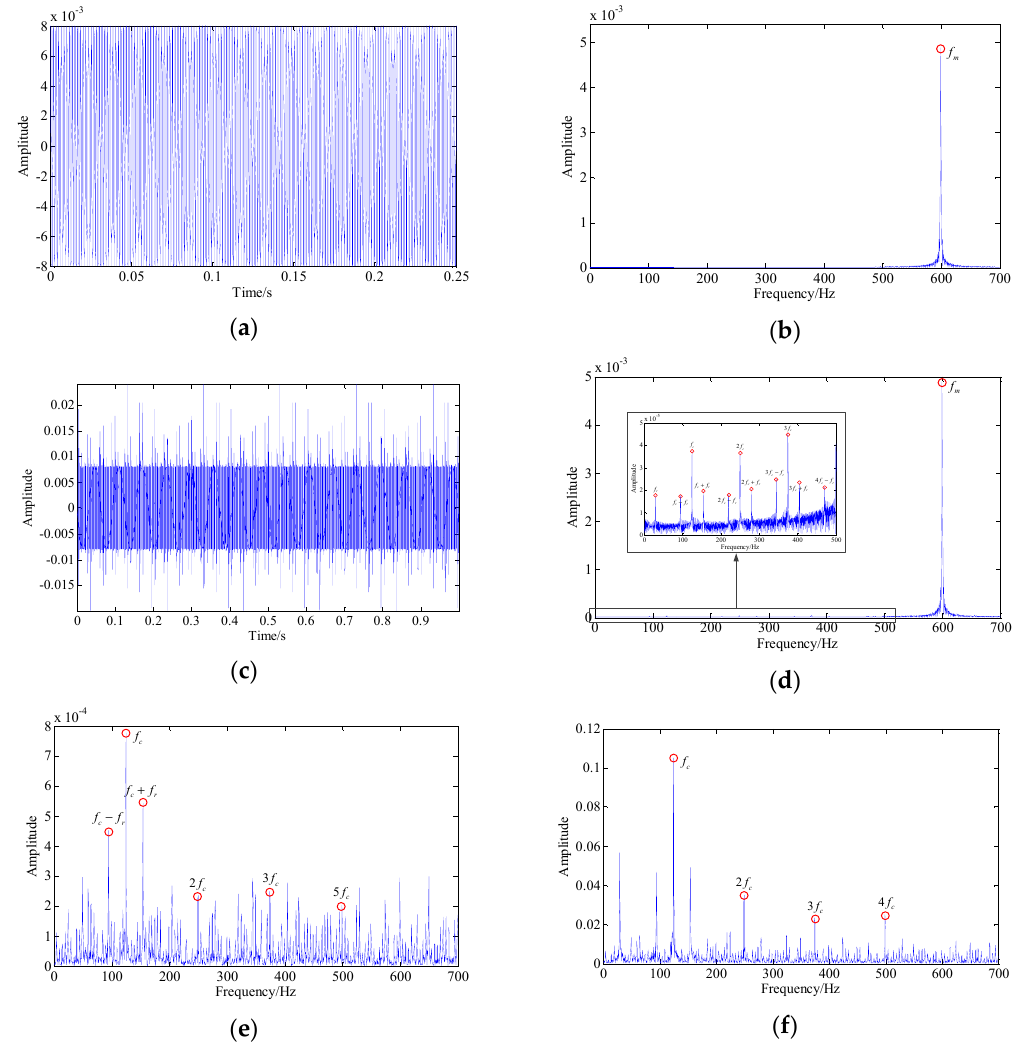
Figure 3. The multi-component signal consists of the signal shown in Figure 1 and the additional interference harmonic signal: ( a , b ) the waveform and spectrum of the added harmonic interference signal; ( c,d ) the waveform and spectrum of the multi-component signal; ( e,f ) the envelope spectrum and instantaneous frequency spectrum of the multi-component signal.